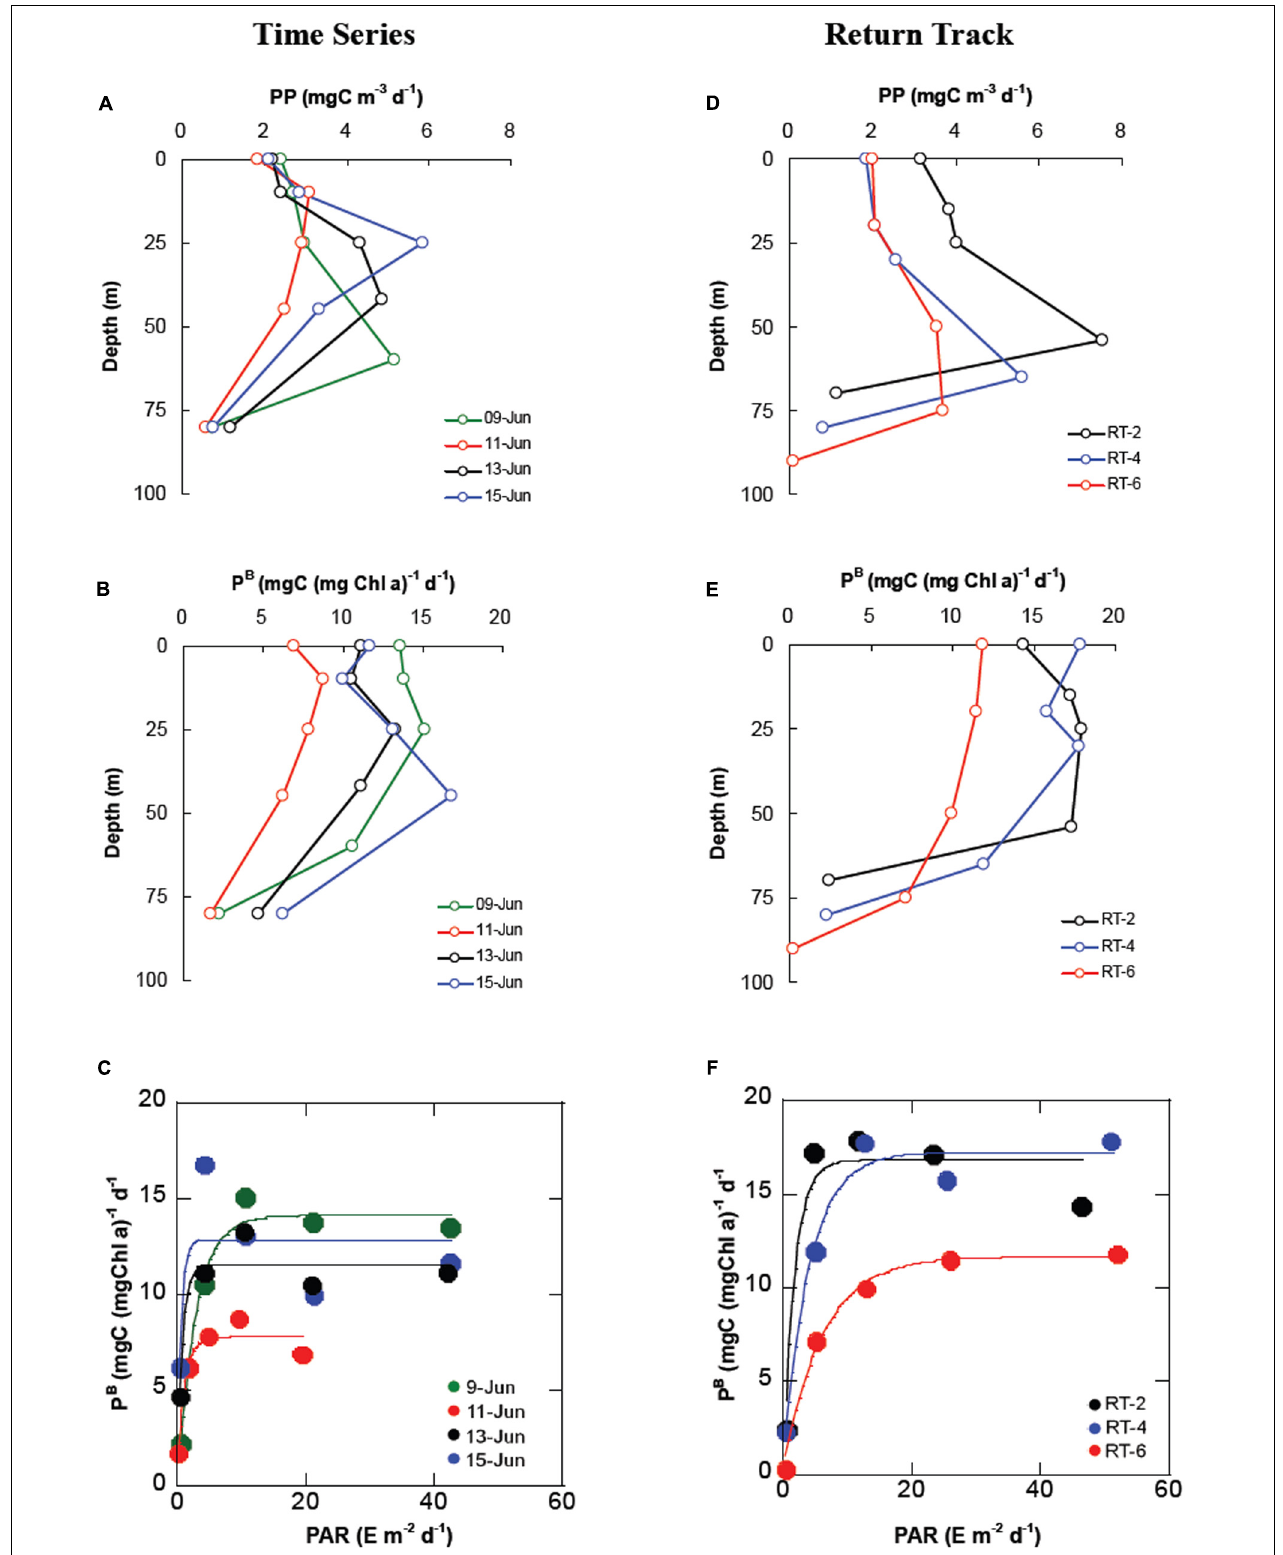
FIGURE 5 | Vertical profiles of primary productivity, chlorophyll a-normalized primary productivity, and daily PAR-P B relationship in the water column for TS (A–C) and RT (D–F) stations.